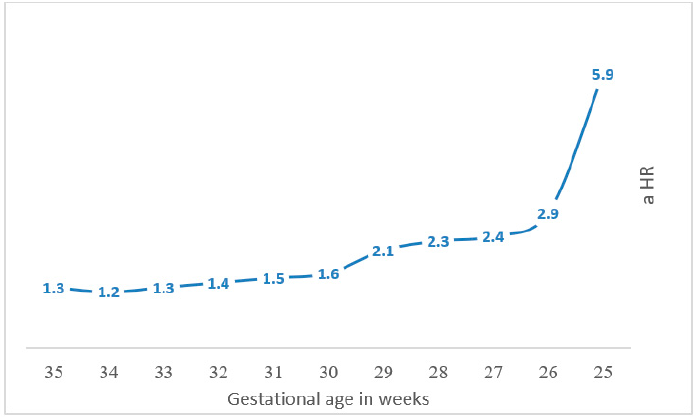
Figure 5. Cox proportional hazard models for long-term neurological morbidity according to gesta- tional age.